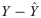
a) Violin graphics to represent the difference of actual data from TDNN model (Y-Y^) for every layer. This graph allows the distribution of the data and its probability density to be easily visualised. b) Direct representation of (Y-Y^). Colour represents the density of points in a given area. Lighter colour (yellow) determines higher data density. It should be noted that both graphs are presented on a logarithmic scale. The differences between predictions are shown in Celsius degrees.